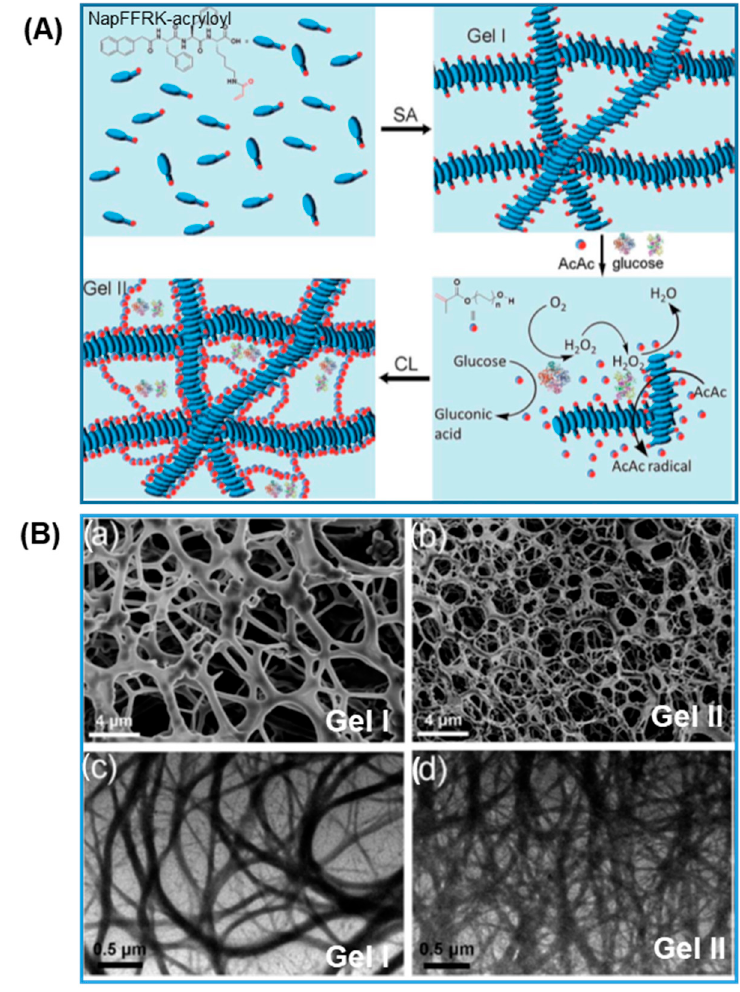
Figure 9. Dual-enzyme catalyzed gelation of NapFFRK-acryloyl based hydrogel. ( A ) Schematics of the formation of pH regulated self-assembly of supramolecular hydrogel (Gel I) and radical polymerized and crosslinked hydrogel (Gel II). ( B ) SEM images of: ( a ) Gel I and ( b ) Gel II; TEM images of: ( c ) Gel I and ( d ) Gel II (adapted with permission from Ref. [68]).